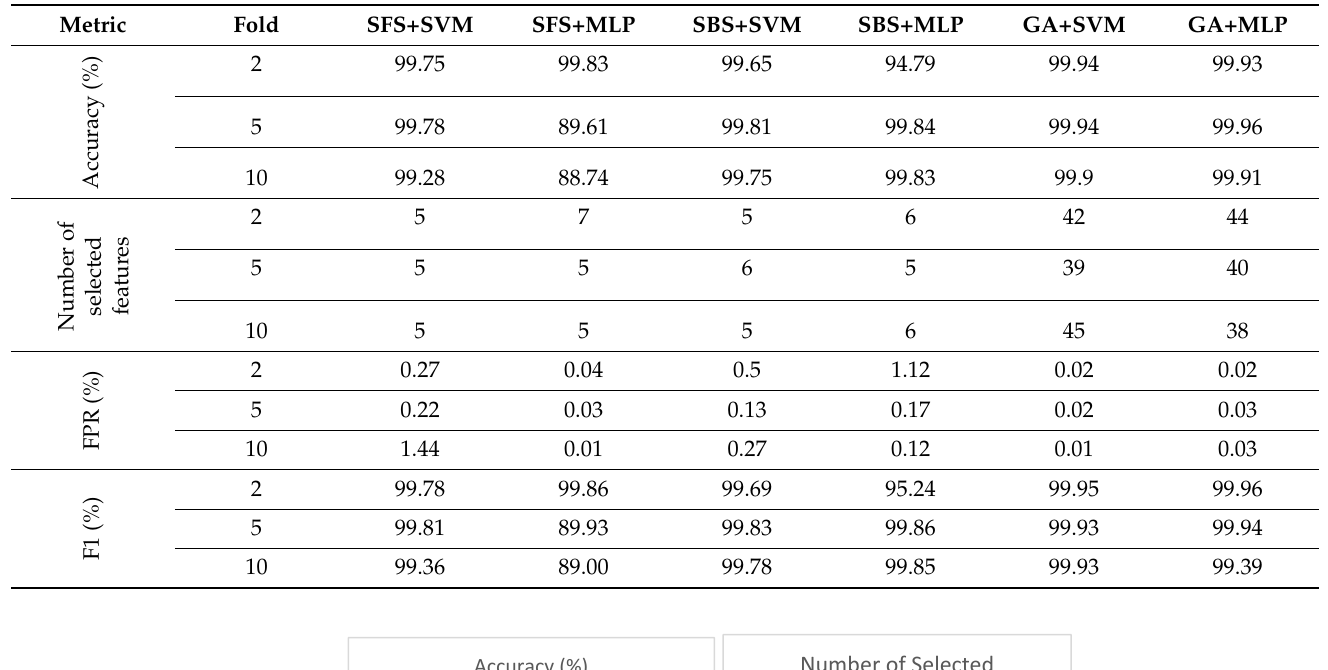
Table 7. Performance of SFS, SBS, and GA using objective function based on accuracy and number of selected features in CIC-IDS-2017.